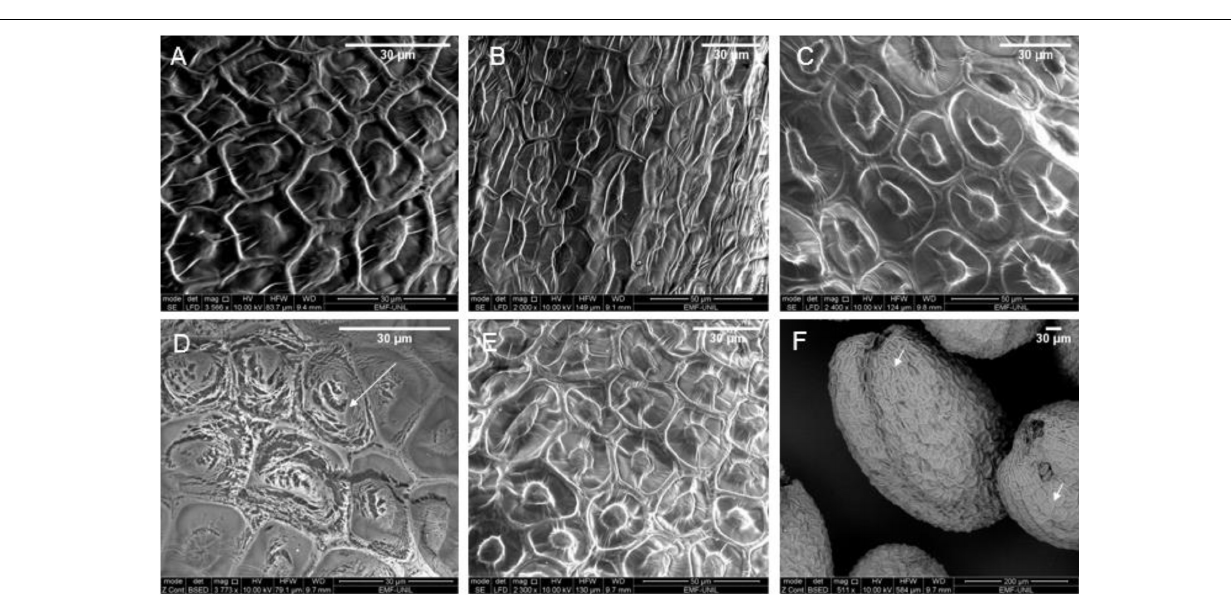
FIGURE 2 | Scanning electron microscopy (SEM) images of Arabidopsis seeds which are (A) untreated, (B) heat-treated for 10 min at 80 ◦ C, (C) plasma-treated for 3 min using honeycomb electrode dielectric barrier discharge (DBD) configuration, (D) plasma-treated for 3 min with stripe electrode DBD configuration; the white arrow points to the eroded area (E) ozone-treated for 10 min at 200 ppm, and (F) ozone-treated for 10 min at 200 ppm of multiple seeds, white arrows point to biological diversity in seed coat patterns. Images at a lower magnification are shown in the Supplementary Figure 1